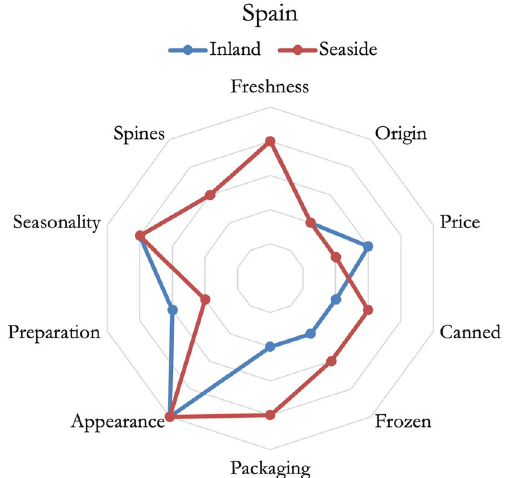
Fig. 6 Importance of fish attributes in defining consumer’s preferences ,